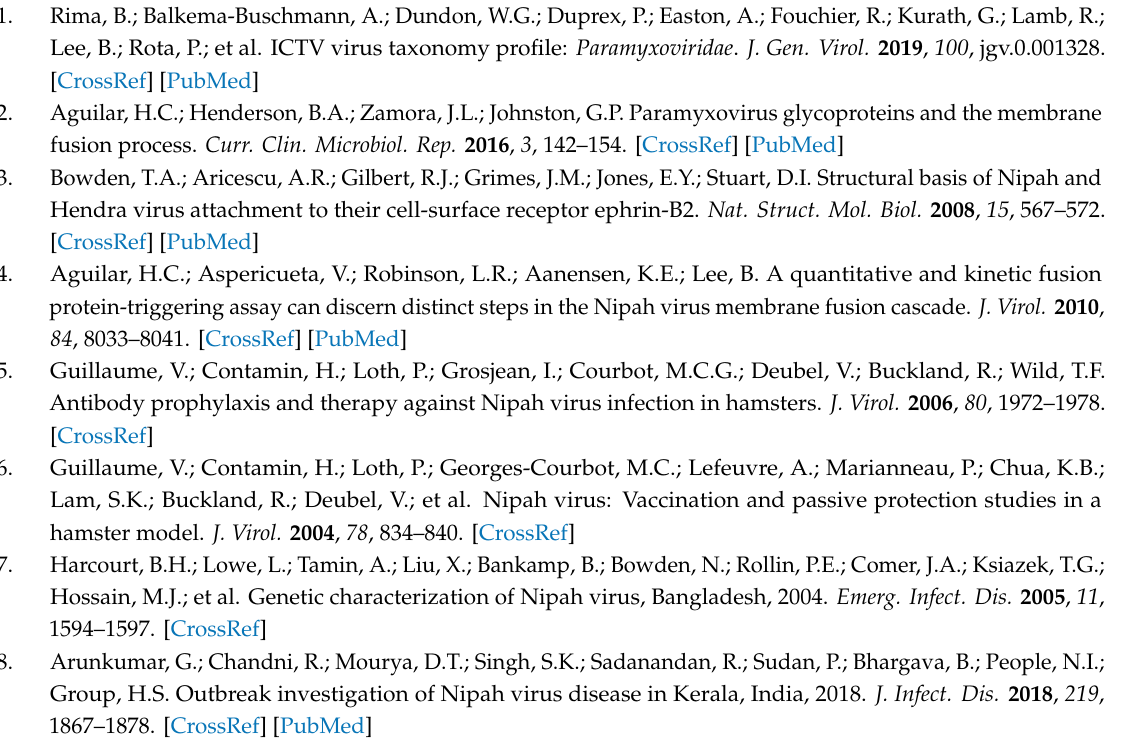
Figure S1. Cells from swine muscle explants support BoHV-4 transduction and replication; Figure S2. Design and expression of Nipah virus glycoprotein F; Figure S3. Design and expression of Nipah virus glycoprotein G; Figure S4. BoHV-4 adaptation and replication in PECs; Figure S5. PECs are permissive for BoHV-1 and BVDV; Figure S6. Pig serum reduces PECs growth; Figure S7. Flow chart of the strategy used to produce BoHV-4-A-CMV-NiV-F ∆ TK and BoHV-4-A-CMV-NiV-G ∆ TK free of bovine antigens; Figure S8. Evaluation of post-vaccinal reactions of immunized pigs and assessment of BoHV-4 vector shedding; Figure S9. Evaluation of gating strategies for ICS analysis of NiV-specific CD8 T cell responses; Figure S10. Flow cytometric gating for ICS analysis of longitudinal PBMC